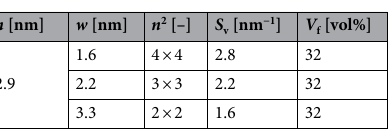
Table 1. Shape parameters of NS-Cu in the